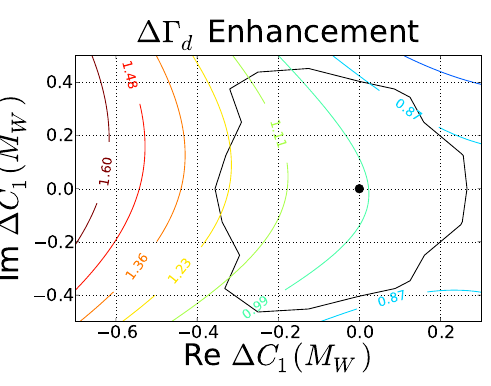
Figure 22 . Enhancements on (cid:1)(cid:0) d when assuming universal NP e(cid:11)ects in C 1 ( M W ). The black dot corresponds to the SM